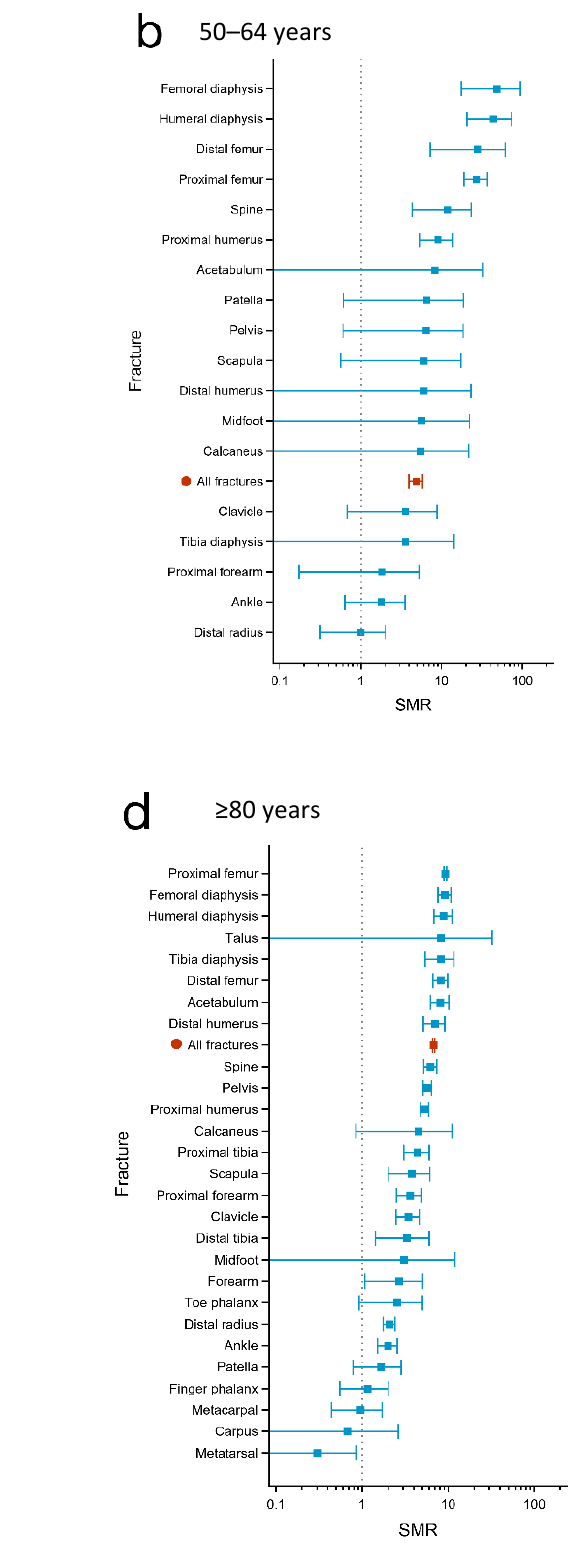
Figure 1. 30-day standardized mortality ratios (SMR) for the different fracture locations in four age groups; ( a ): 16–49 years; ( b ): 50–64 years; ( c ): 65–79 years; and ( d ): ≥ 80 years. The dots represent SMR, and the horizontal lines represent the 95% confidence intervals.